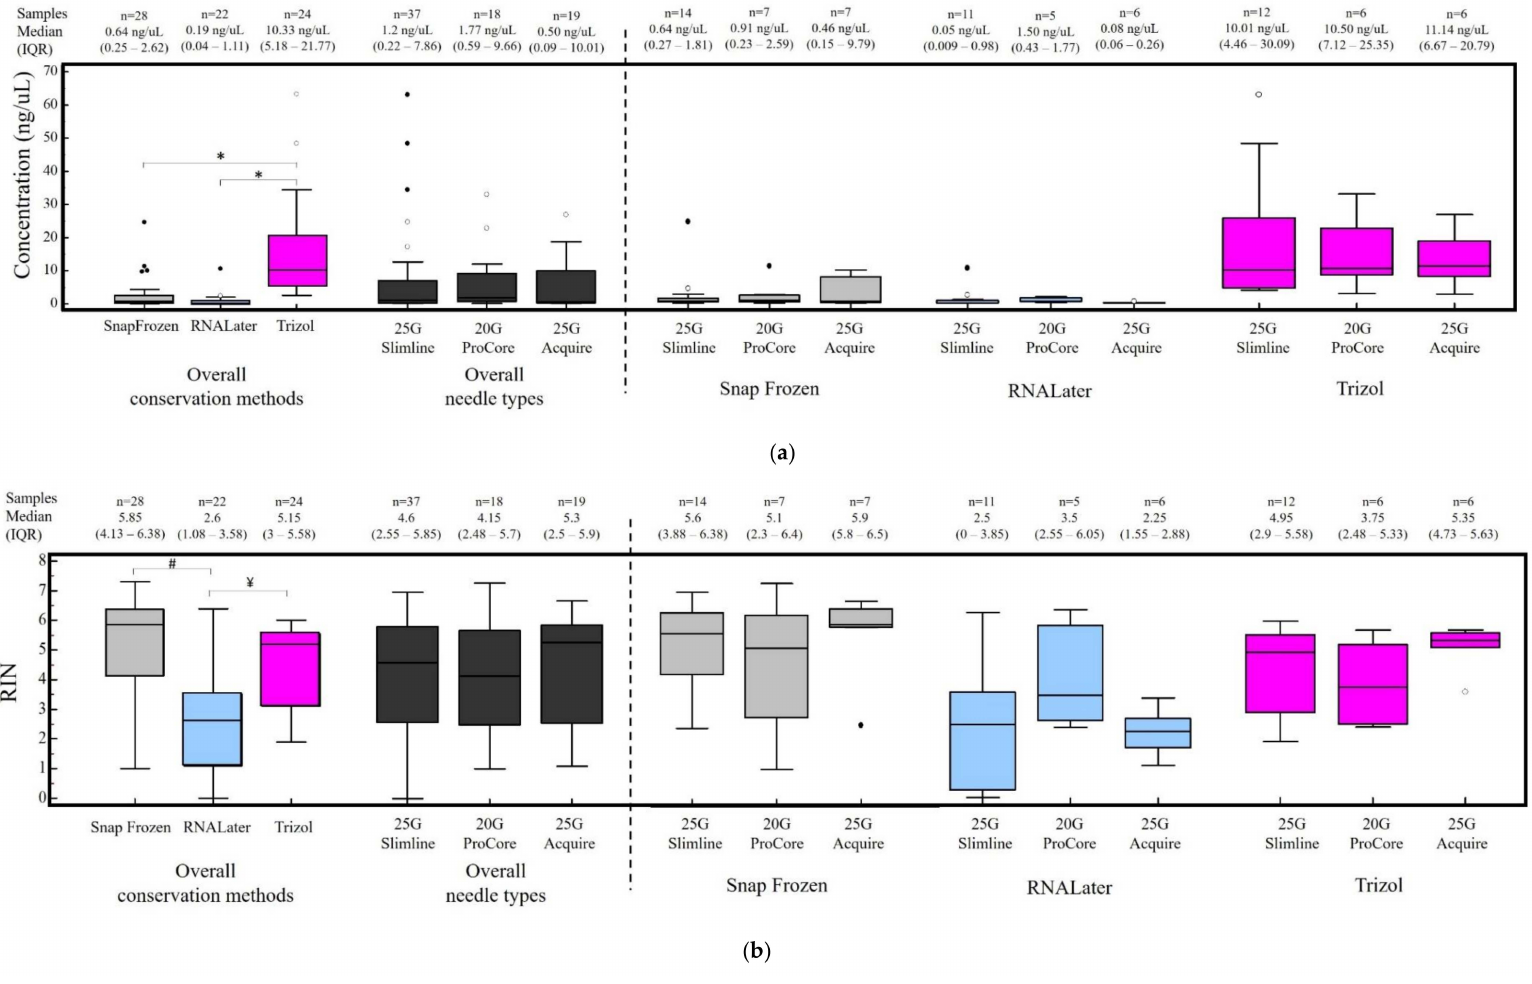
Figure 2. Final RNA concentration ( panel a ) and RNA Integrity Index (RIN) ( panel b ) in relation to the conservation method and needle type. * p < 0.0001; # p = 0.07 ¥ p =